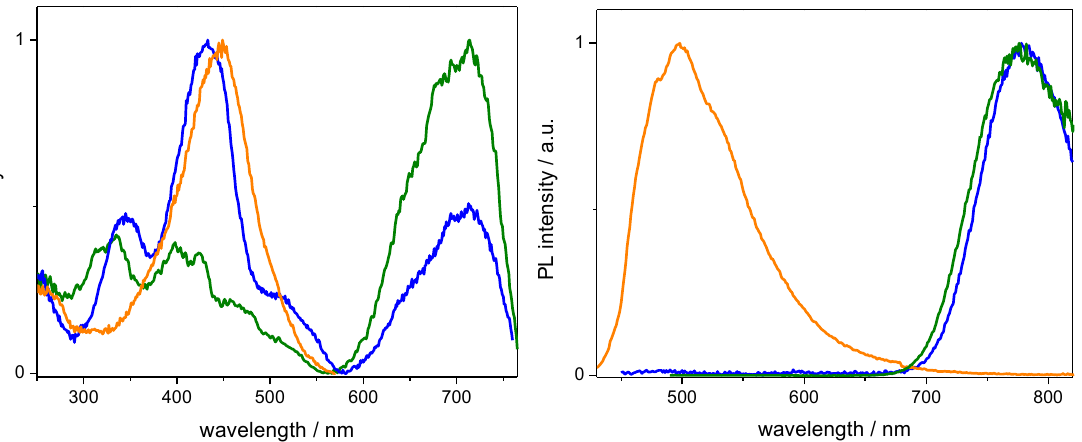
Figure 3. Normalized excitation ( left ) and emission ( right ) spectra of Curc@MSN (orange), 4@MSN (green) and CB-Green@MSN (blue), recorded from 0.3 mg/mL cyclohexane suspensions at λ em = 780 nm and λ exc = 420 nm, respectively.